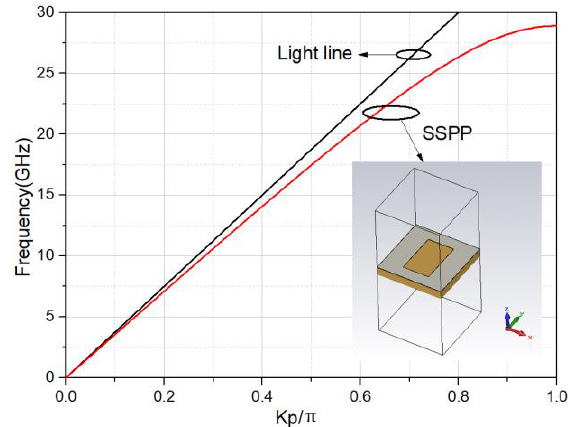
Figure 2. The dispersion curve of the SSPP unit cell.